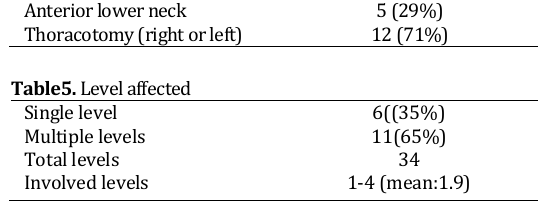
Table 4. Distribution of the surgical incisions Anterior lower neck